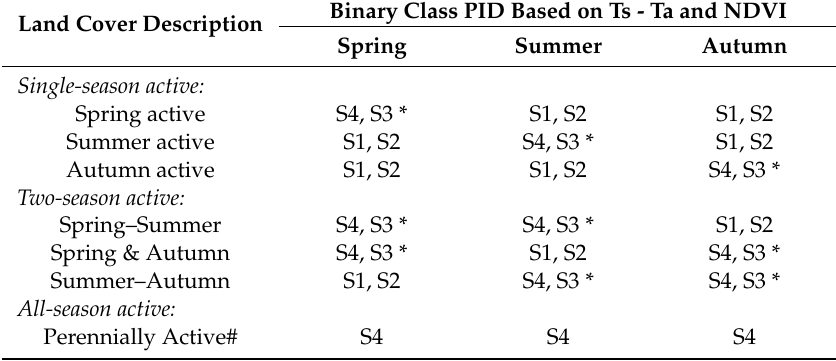
Table 2. Land cover classification criteria.